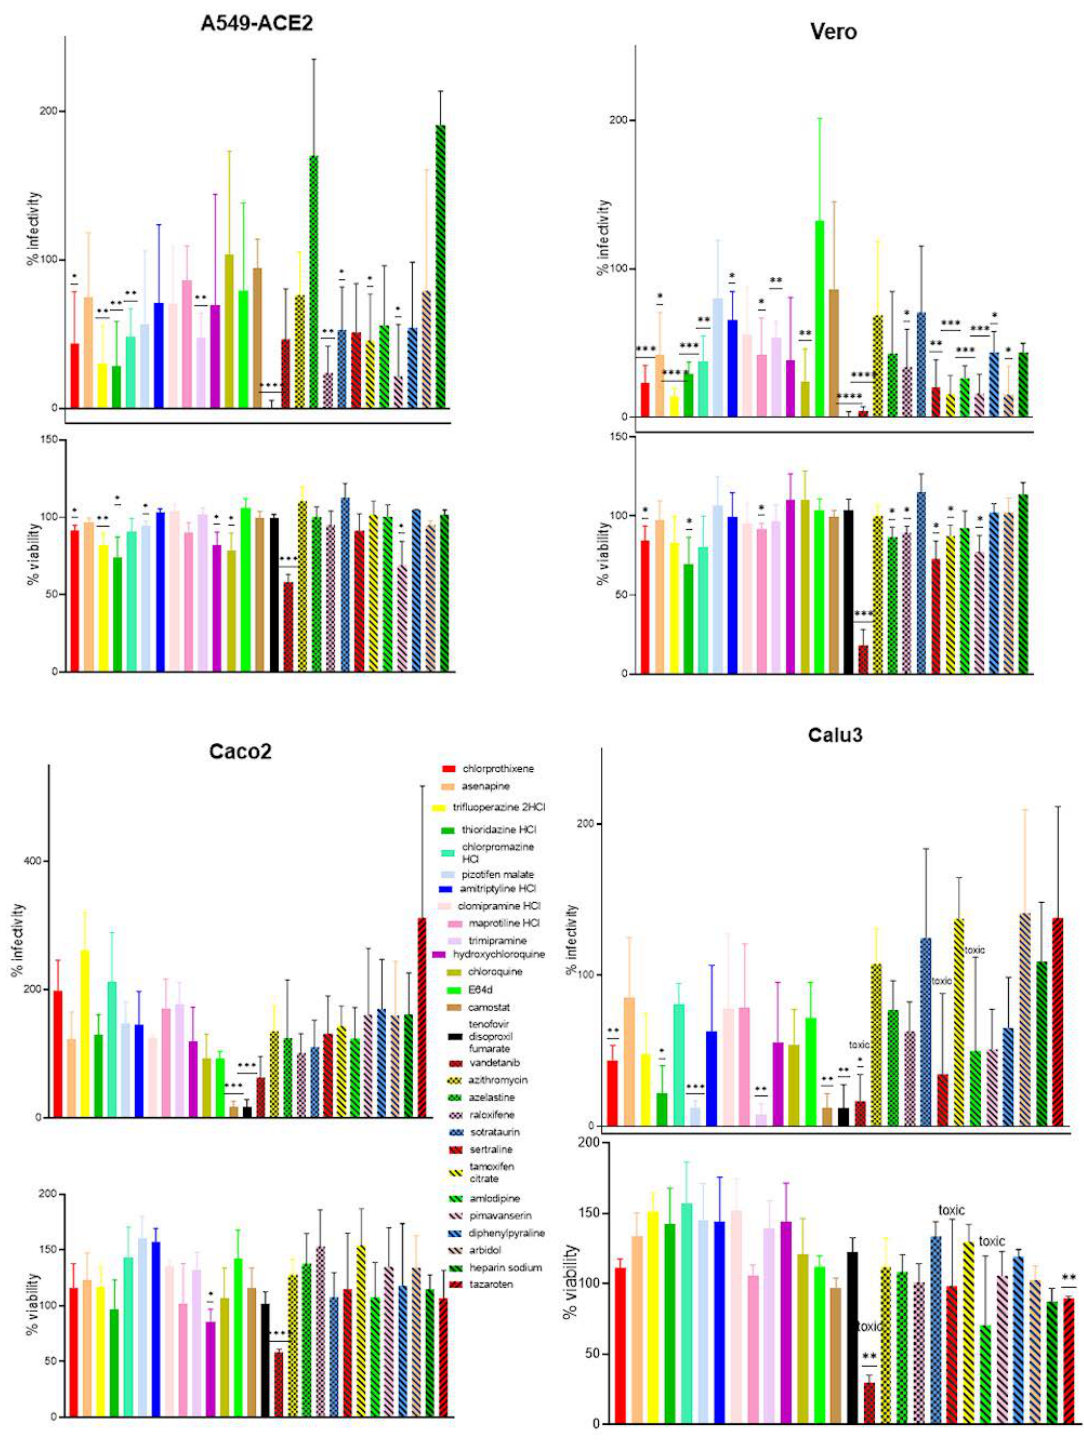
Figure 7. Kite-shaped molecules inhibit infectivity of SARS-CoV-2 pseudovirus in kidney and lung epithelial cells. Mouse leukemia virus pseudotyped with spike protein (S) from severe acute respiratory syndrome coronavirus-2 was used to infect A549-ACE2, Vero, Caco2, and Calu3 cells, respectively, in a 96-well plate for 48 h in the presence of drugs with 1 h pre-treatment. Infectivity was measured as luciferase activity and expressed as % infectivity to infected, own solvent control (dimethyl sulfoxide or water). Viability was measured by XTT assays in un-infected cells and expressed as % viability to solvent control (dimethyl sulfoxide or water). Data are presented as mean ± SD of three-six repeats. Statistically significant differences are represented by * p < 0.05, ** p < 0.01, *** p < 0.001, and **** p <